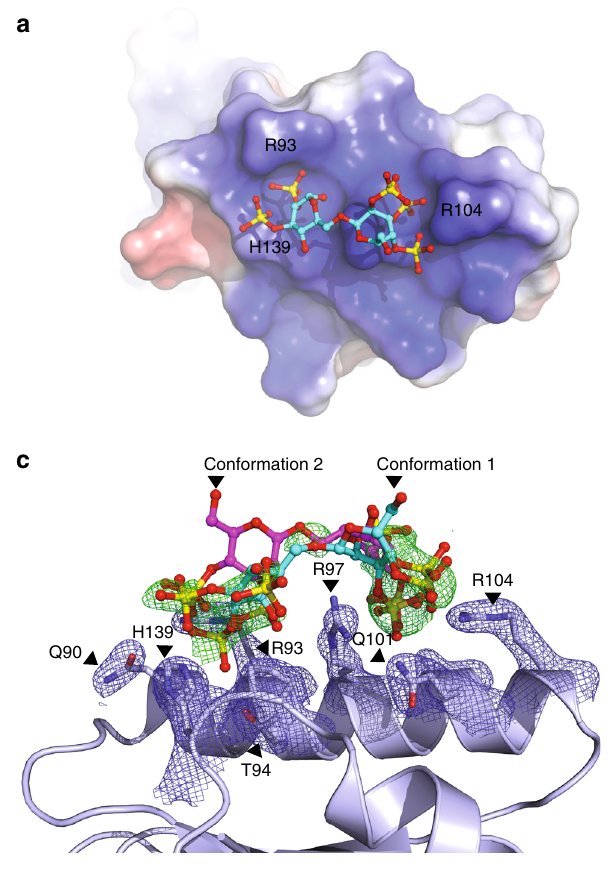
Fig. 3 Structure of PCSK9 in complex with a dextran sulfate disaccharide. a Structure of dextran sulfate disaccharide on the electrostatic surface ( blue : positive; red : negative) of the pro-domain of PCSK9 (PDB ID: 5OCA) with amino acids indicated (H: histidine and R: arginine). b Side view of the binding site containing conformation 1 of dextran sulfate with interacting residues indicated (Q: glutamine, T: threonine). c Simulated annealing Fc-Fo composite omit map (positive density show in green and contoured at 3 σ ) of dextran sulfate in two alternative conformations (con fi rmations 1 ( cyan ) and 2 ( magenta )). Interacting residues of PCSK9 are indicated and show together with a simulated annealing 2Fc-Fo composite omit map ( blue and contoured at 1 σ